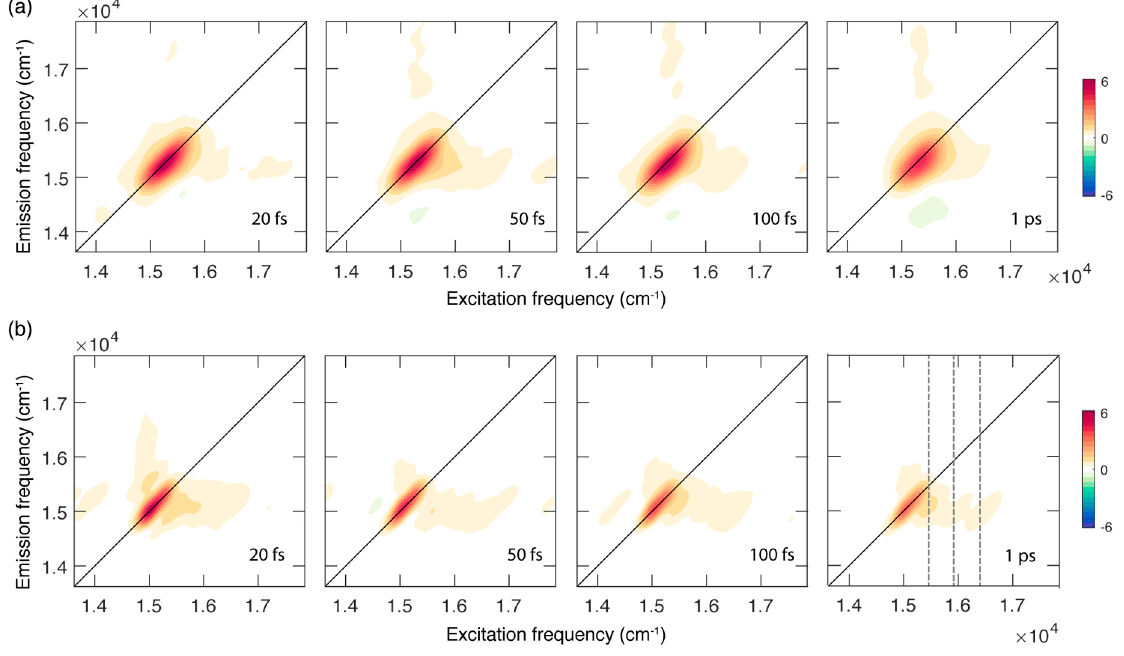
Figure 2. Absorptive 2DES maps of chl b in a mixture EtOH:MeOH 4:1 recorded at room temperature ( a ) and at 77 K ( b ) at selected values of population time. Grey dashed lines in the map at a population time of 1 ps at 77 K pinpoint the position of the main vibronic features at an excitation energy of 15,400, 15,990 and 16,400 cm − 1 .